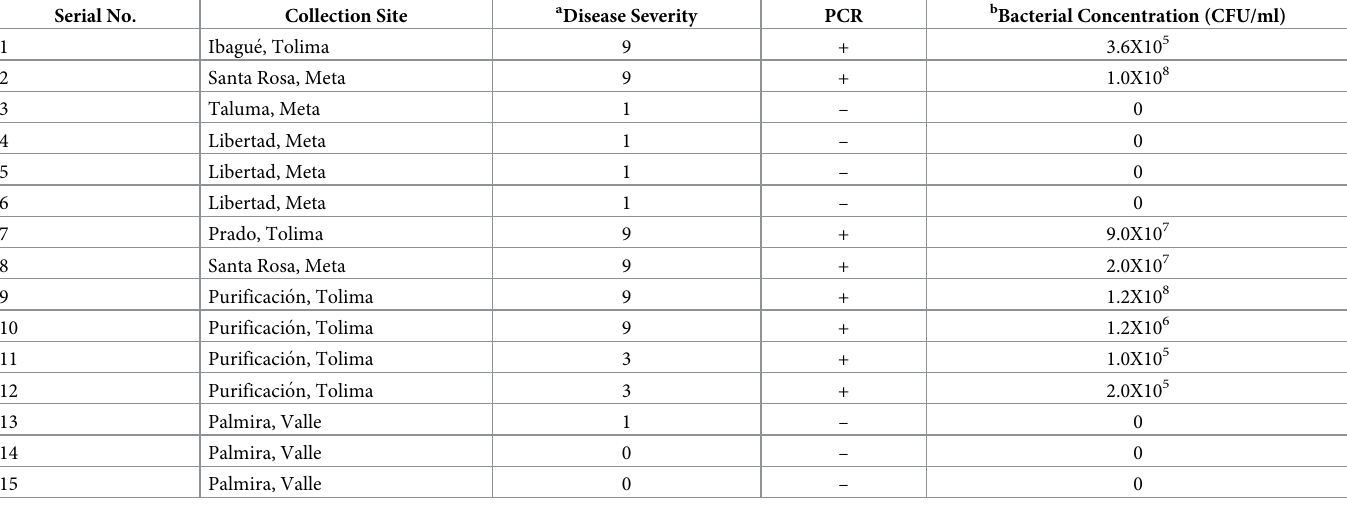
At least 10 5 CFU/ml of B . glumae was detected in PCR-positive samples (Table 2), correspond- ing to samples with severity score higher than 3. Identical results were obtained in two inde- pendent experiments for bacterial quantification and DNA extraction. Table 2. Seed samples used to test diagnostic primer specificity and sensitivity. Serial No.